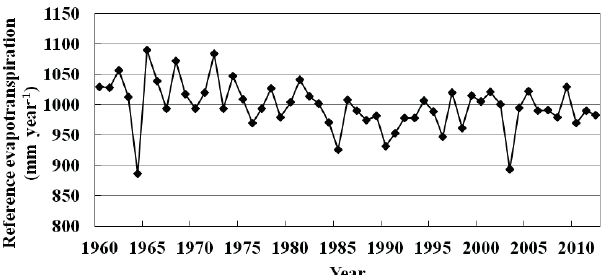
Fig. 5 Change of annual reference evapotranspiration averaged from the 45 stations in Hai River basin from 1960 to 2012.